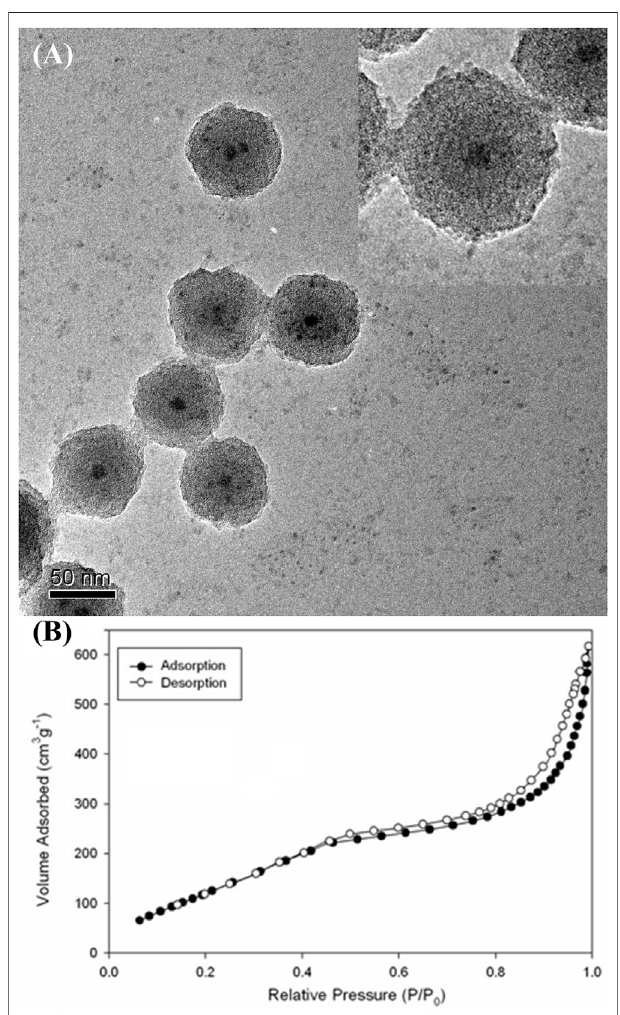
FIGURE 8 | (A) TEM image and (B) N 2 adsorption ( fi lled circles) and desorption (empty circles) isotherms of the iron nitride at silica nanoparticles with further coated mesoporous silica outer shell (The inset shows higher- magni fi cation TEM image).